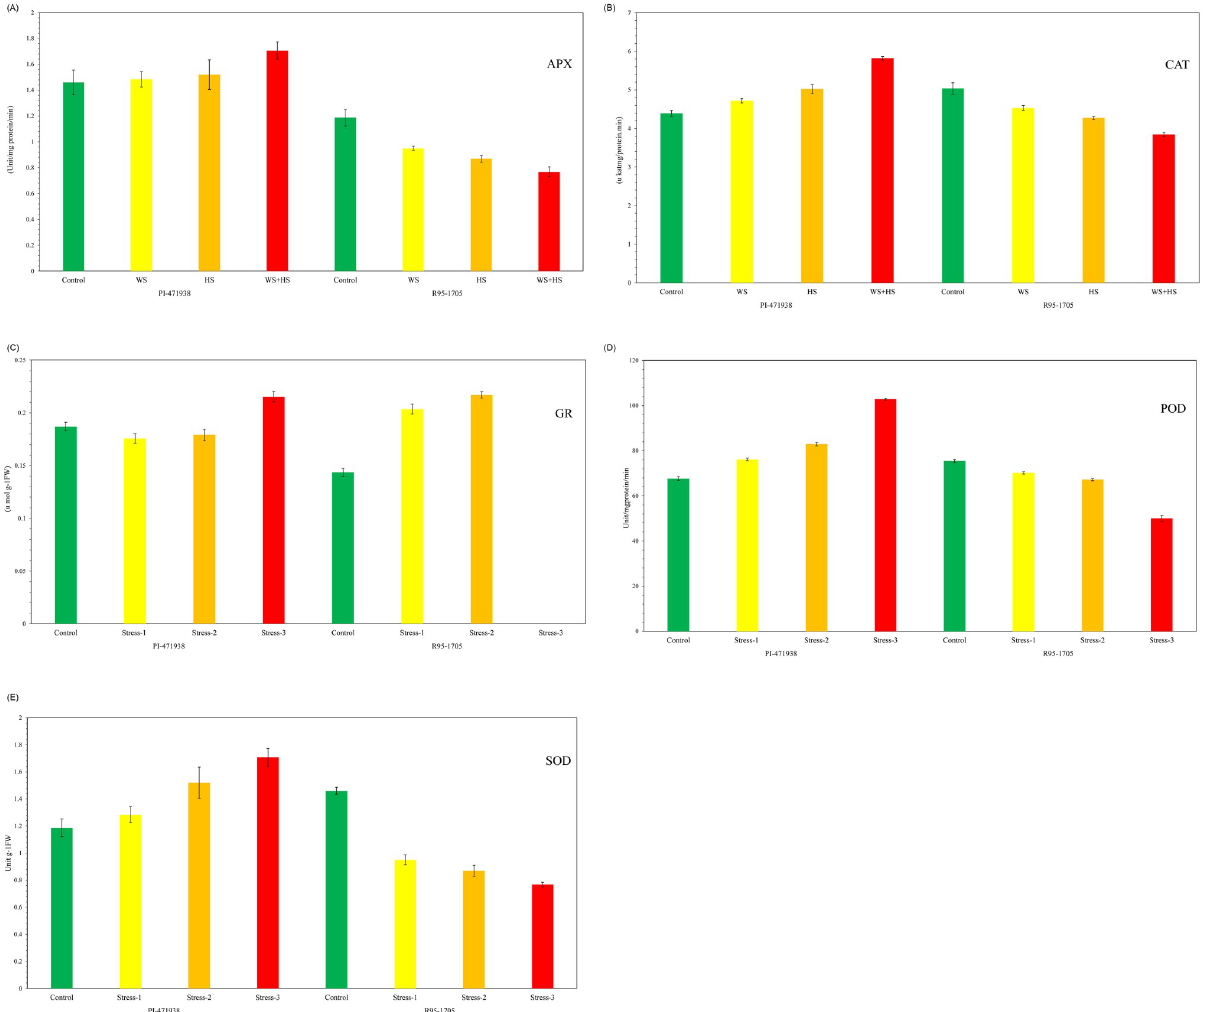
Fig 10. Enzyme activities under water stress, heat stress and the combined stresses. The activity is measured in terms of fold change over the control. C: Control; WS: Water stress; HS: Heat stress; WS+HS: Water and Heat stress.